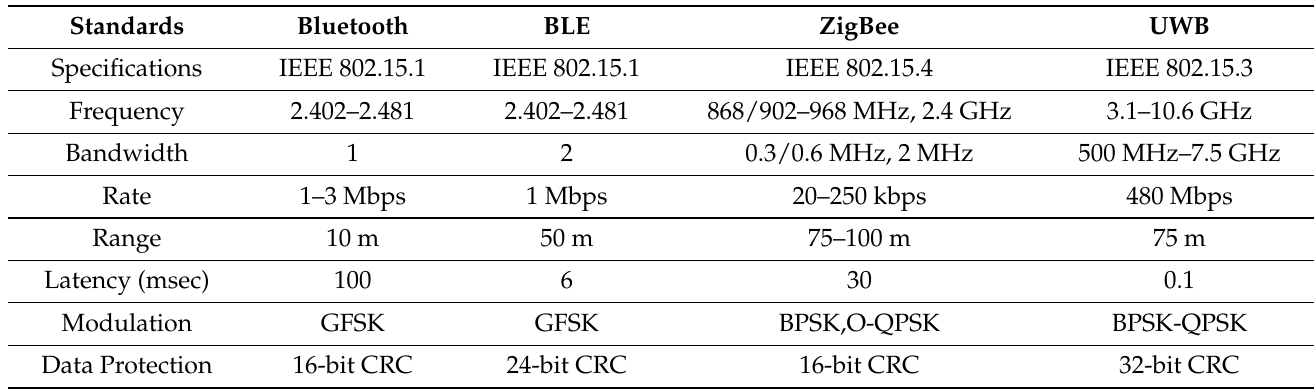
Table 5. Comparison of short-range